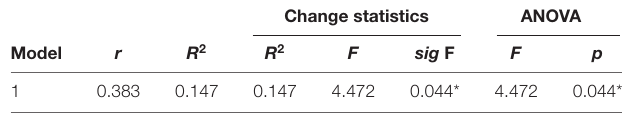
TABLE 6 | Impact analysis, change statistics and analysis of variance for the model involving miss N-back and mean RR. Change statistics ANOVA